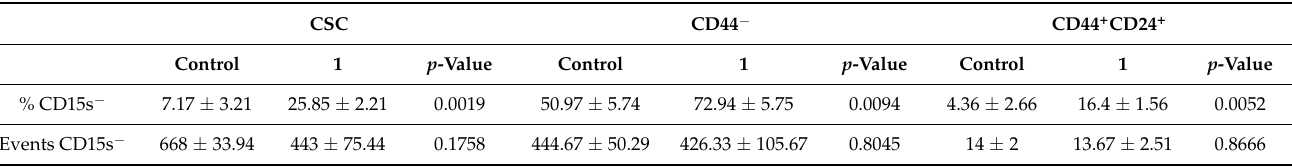
Table 4. Percentage and events of CD15s − cells in CSC, CD44 − and CD44 + CD24 + subpopulations after treatment with com- pound 1.